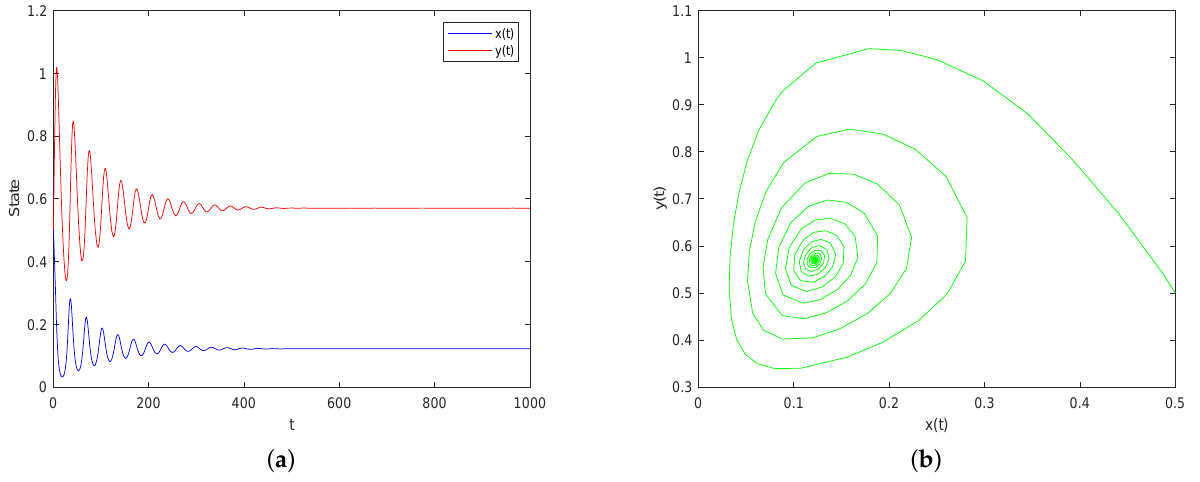
Figure 2. ( a ) Time series and ( b ) phase portrait of E ∗ for system (1) when τ 1 = 3.5 and τ 2 = 0. Other parameters are the same as in